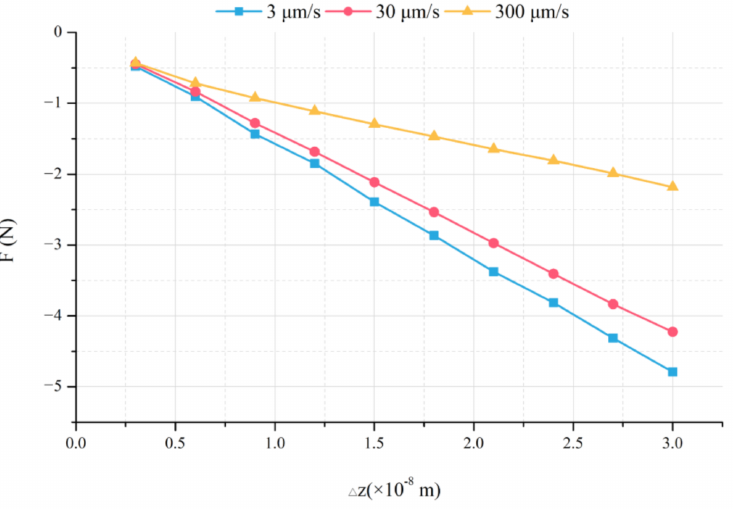
Figure 4. Variations of oil film forces with displacement and velocity